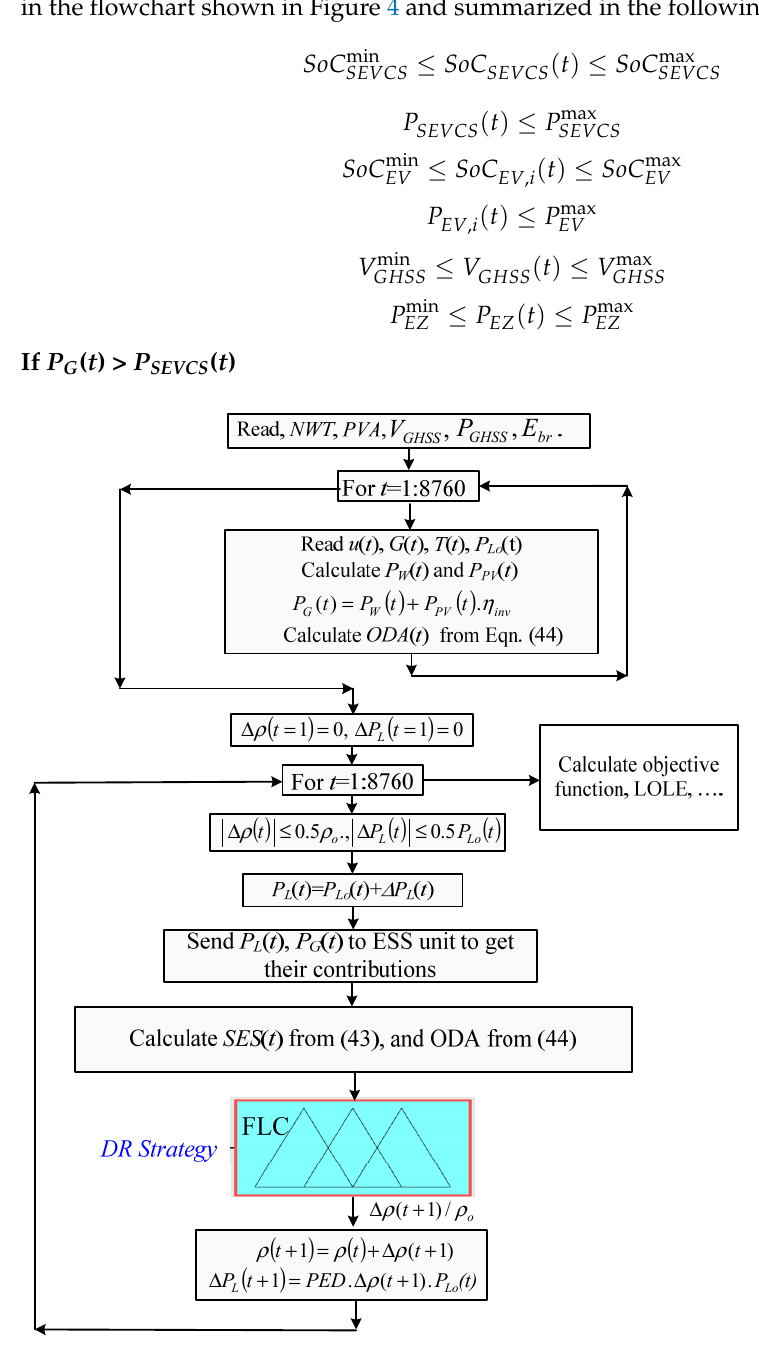
Figure 4. The power dispatch and DR strategies with the SEVCS.